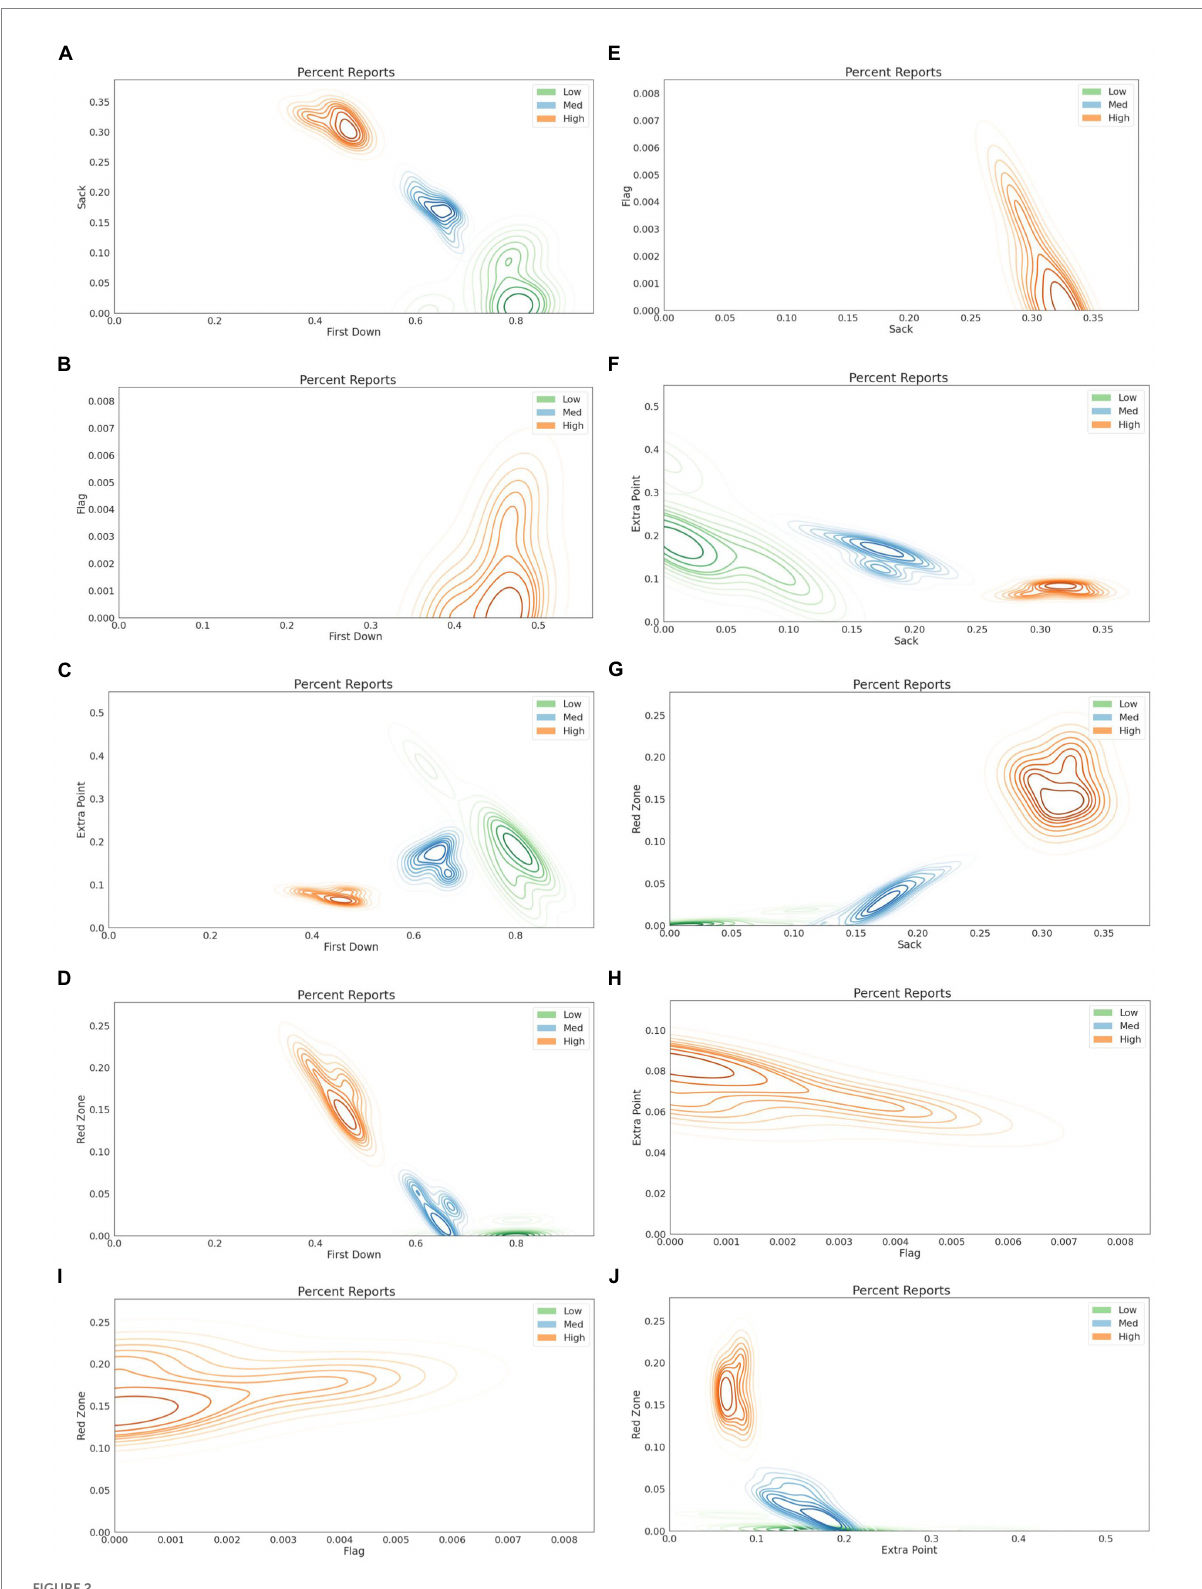
FIGURE 2 Sample clustering visualizations for a single classroom, showing distributions of percent reports for first down vs. sacks (A) , first down vs. flags (B) , first down vs. extra points (C) , first down vs. red zones (D) , sacks vs. flags (E) , sack vs. extra points (F) , sacks vs. red zones (G) , flags vs. extra points (H) , flags vs. flags (I) , and extra points vs. red zones (J)